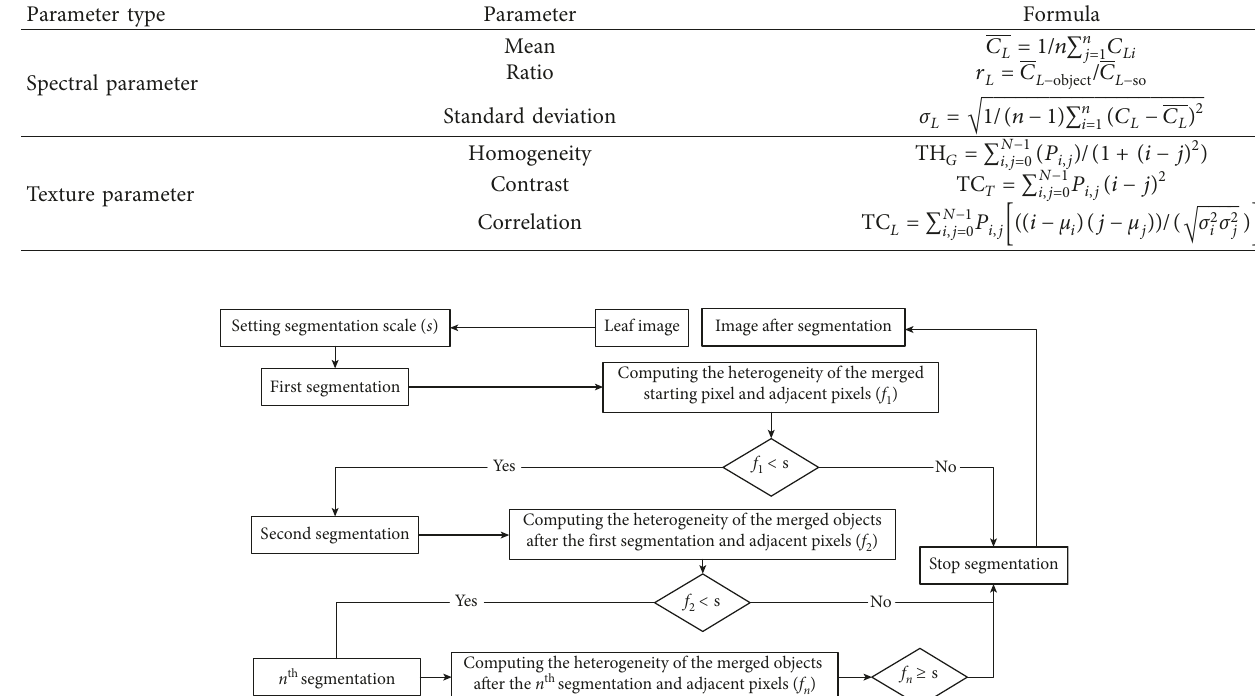
Table 2: Parameters for extraction of